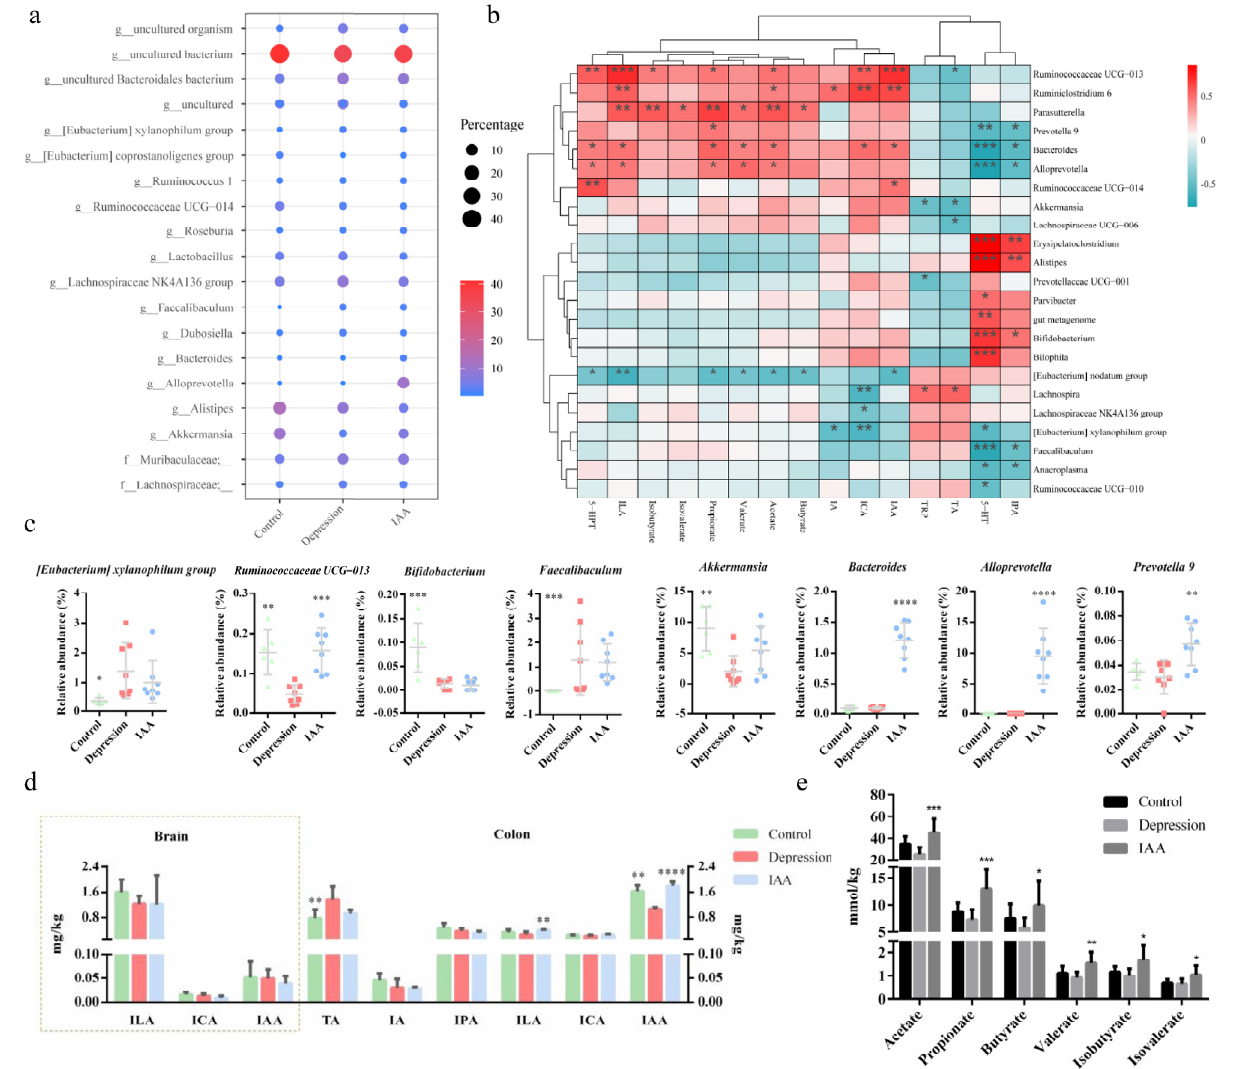
Figure 6. Analysis of bacterial genera in the colon content and metabolites of the gut microbiota. ( a ) Colonic microbial analysis at the genus level. ( b ) Correlation of metabolites and bacterial genera. ( c ) Differential analysis of bacteria at the genus level. ( d ) Quantification of indole derivatives in the content of colon and brain. ( e ) Concentrations of SCFA secreted from the gut microbiota in the cecum. * p < 0.05, ** p < 0.01, *** p < 0.001, **** p < 0.0001 compared with the depression group, data are presented as means ± SD, one-way ANOVA followed by Tukey’s